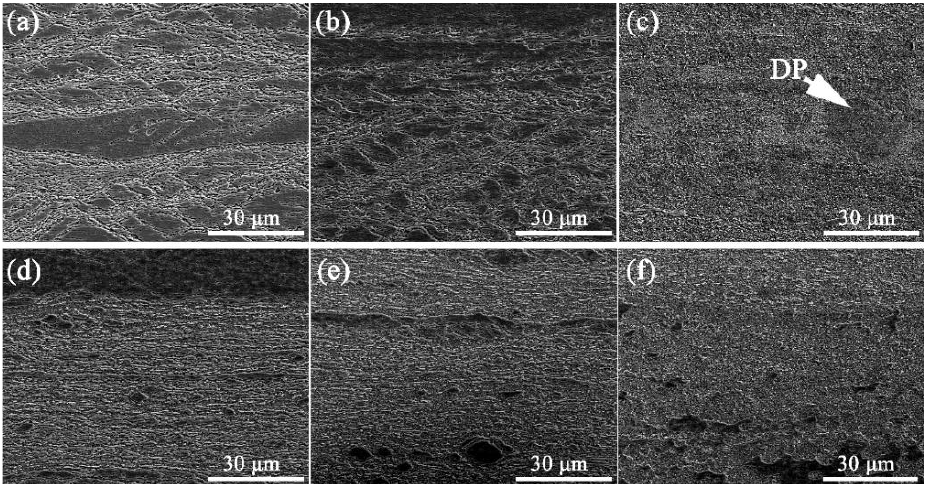
Figure 4. The evolution of microstructures of the Cu-Ni-Si alloy during the two steps of aging treatment containing the first step aging at 500 ◦ C for ( a ) 0.25 h, ( b ) 0.5 h, and ( c ) 3 h, and the second step aging at 450 ◦ C for ( d ) 0.25 h, ( e ) 0.5 h, and ( f ) 3